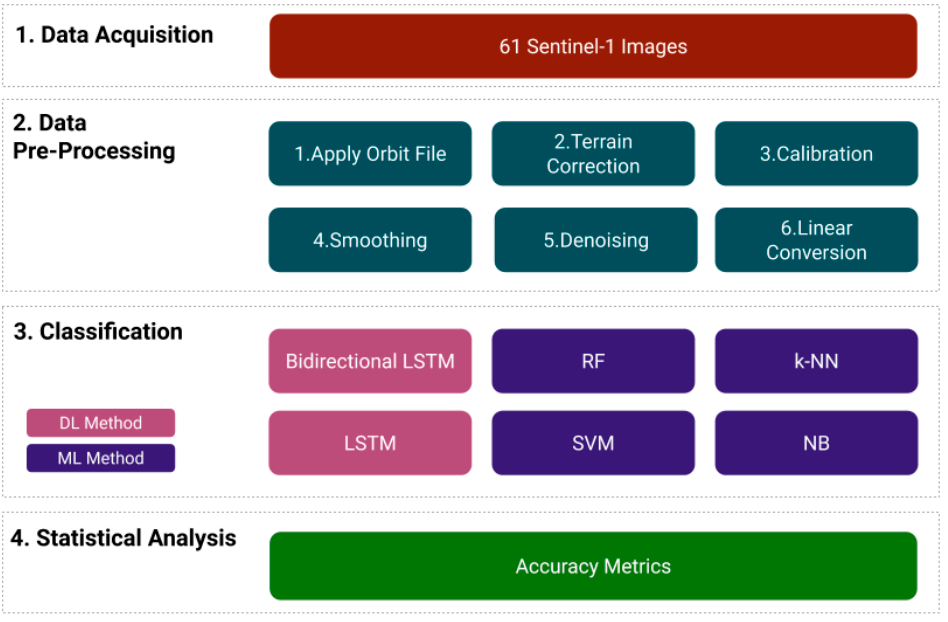
Figure 2. Methodological flowchart.